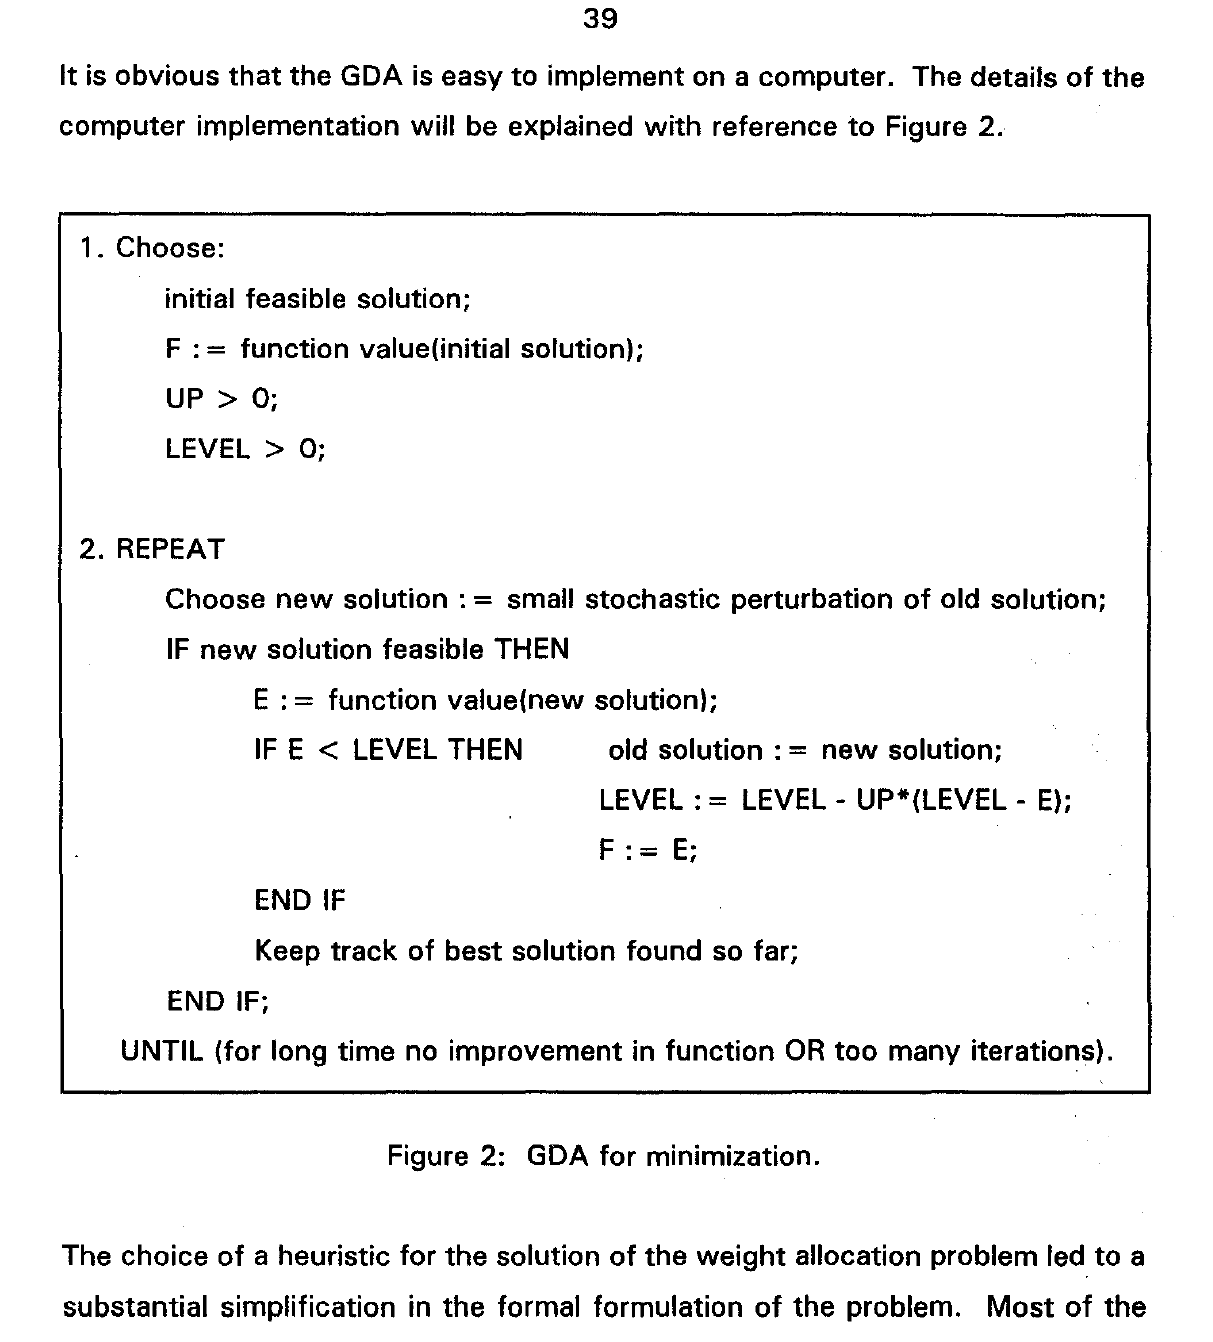
Figure 2: GDA for